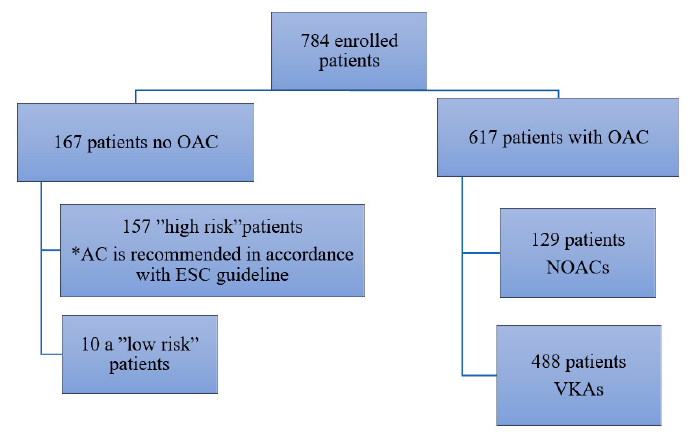
Figure 1. Patients distribution regarding the OAC treatment.